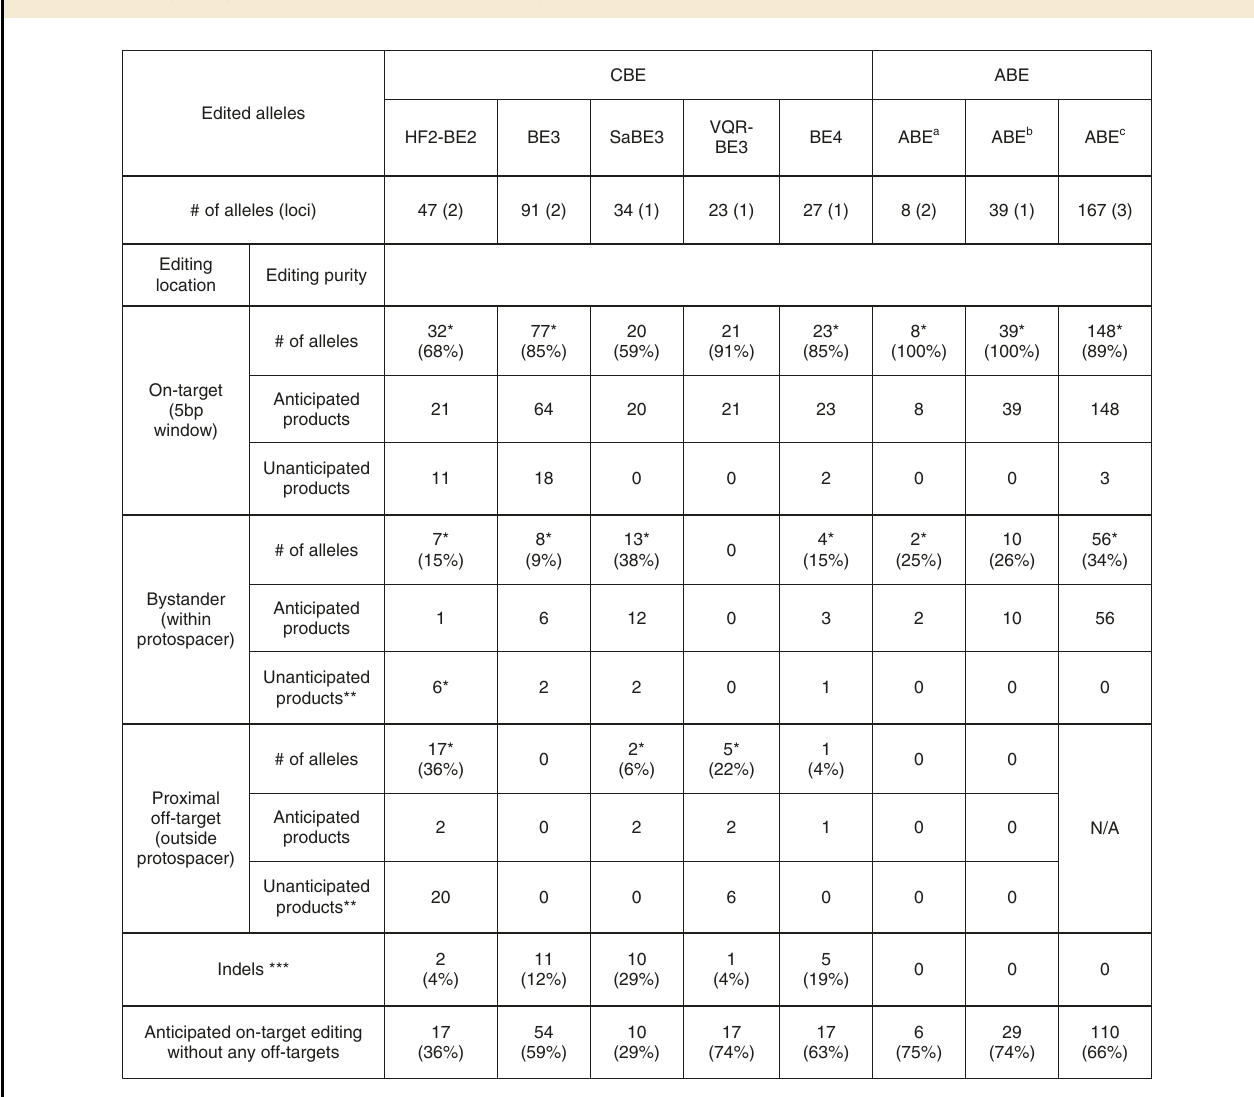
Table 1 Summary of cytosine and adenine base editing results